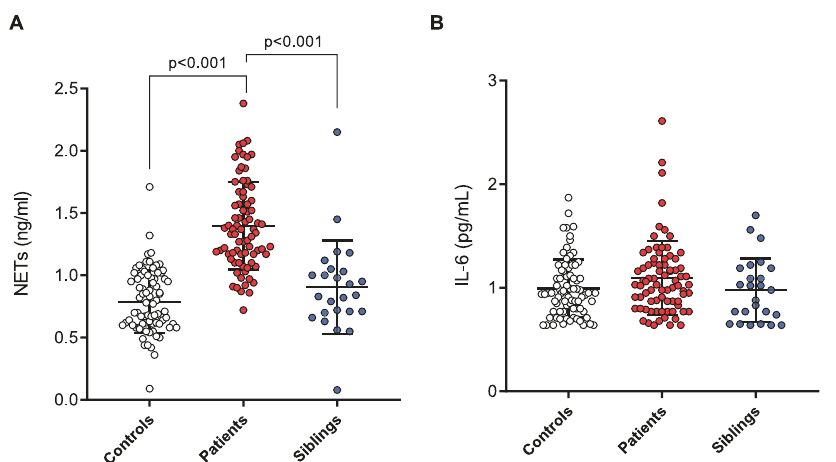
Fig. 1 Group differences in the concentration of plasma NETs and IL-6. A Plasma NETs (ng/mL) are signi fi cantly elevated in early schizophrenia patients ( n = 78) compared to both their unaffected siblings ( n = 25) and community controls ( n = 78). B Plasma IL-6 (pg/mL) levels did not differ among the groups. One-way analysis of covariance with Bonferroni post-hoc adjusted for sex, BMI, tobacco smoking, and other psychoactive drug use. NETs and IL-6 (mean, SD) are represented as natural-log transformed values.